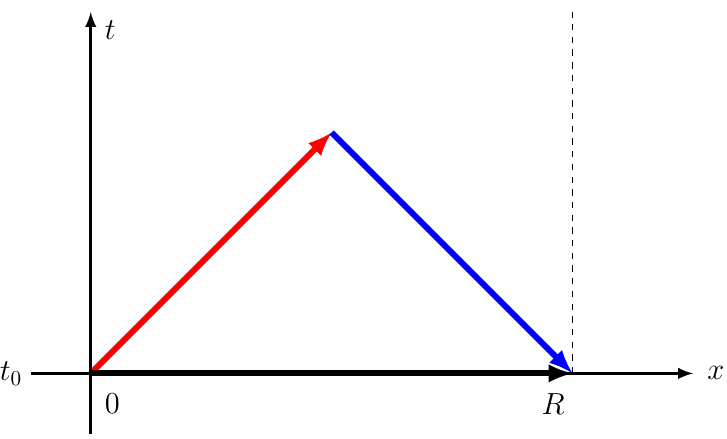
Figure 3 . The integration contour along the time slice t = t 0 (black arrow) in eq (1.20) can be replaced by an integration contour along the characteristics: x (cid:0) = t 0 with 0 < x + < t 0 + R (red arrow) and x + = t 0 + R with t 0 < x (cid:0) < t 0 (cid:0) R (blue